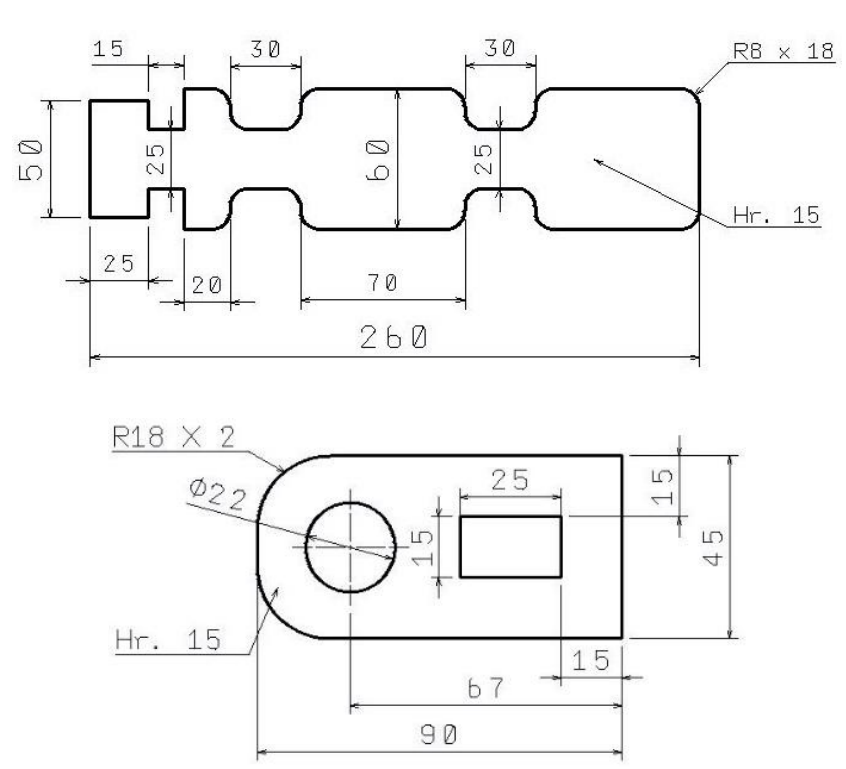
Figure 8. Dimensions of the hammer and its clamping part are in millimeter.